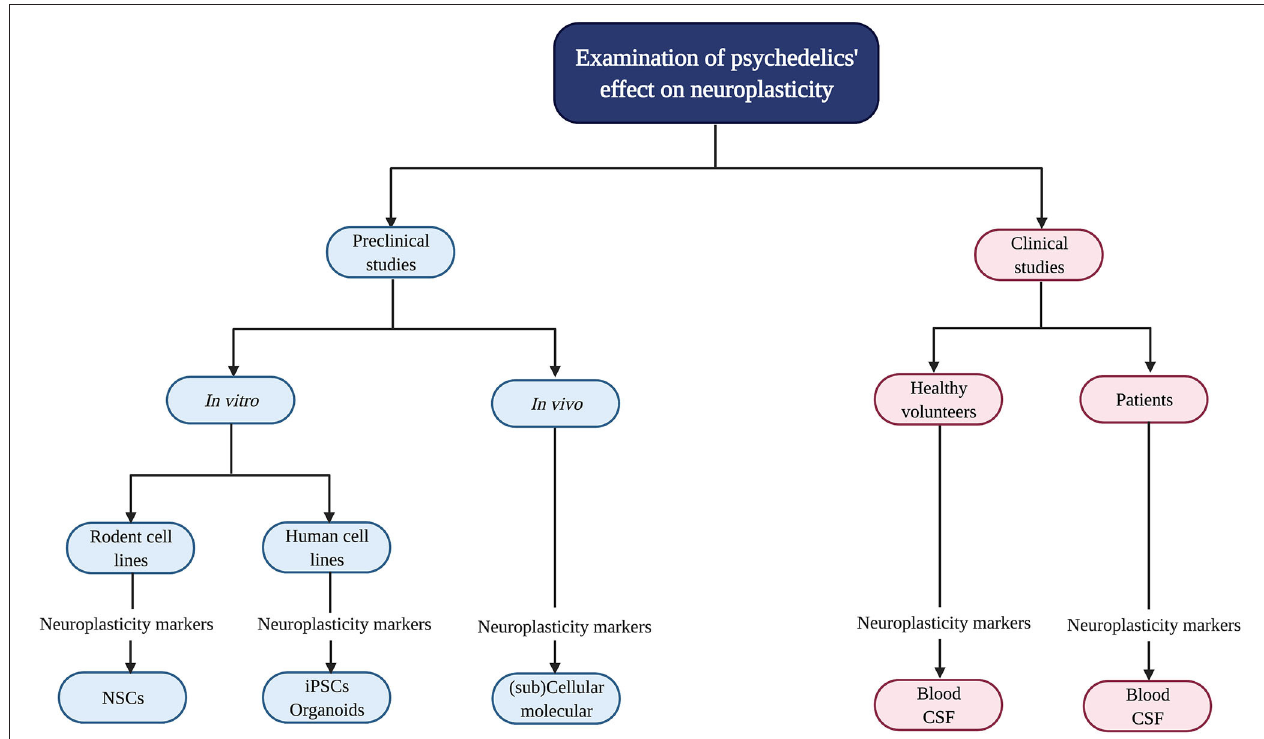
FIGURE 2 | Evaluation of psychedelics’ influence on cellular and molecular neuroplasticity in preclinical and clinical studies. Schematic overview of the current methods to study the neuroplastic effects of psychedelics at a molecular and cellular level. NSCs, Neural stem cells; iPSCs, induced pluripotent stem cells.